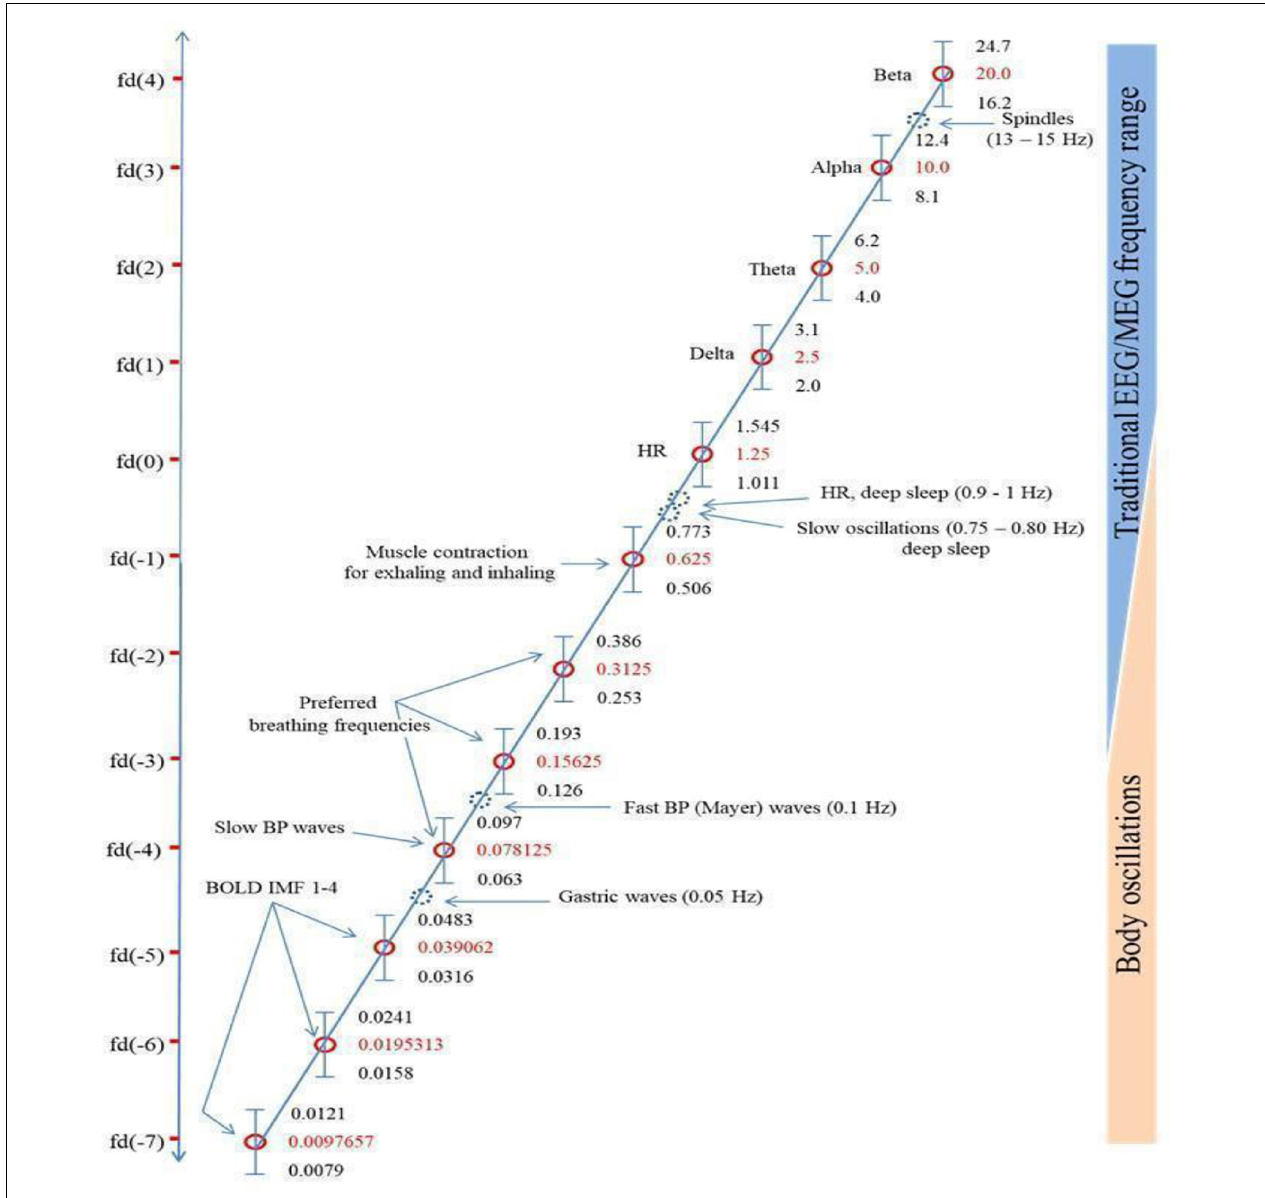
FIGURE 1 | Klimesch’s (2018) figure illustrating the Binary Hierarchy Brain Body Oscillation Theory frequency architecture. Frequency bands, calculated according to the “golden mean rule” (see Klimesch, 2018), are depicted as vertical bars (bandwidths relative to the y -axis are not to scale). Frequencies lying outside the predicted bands are represented as dashed blue circles and are considered falling outside the binary